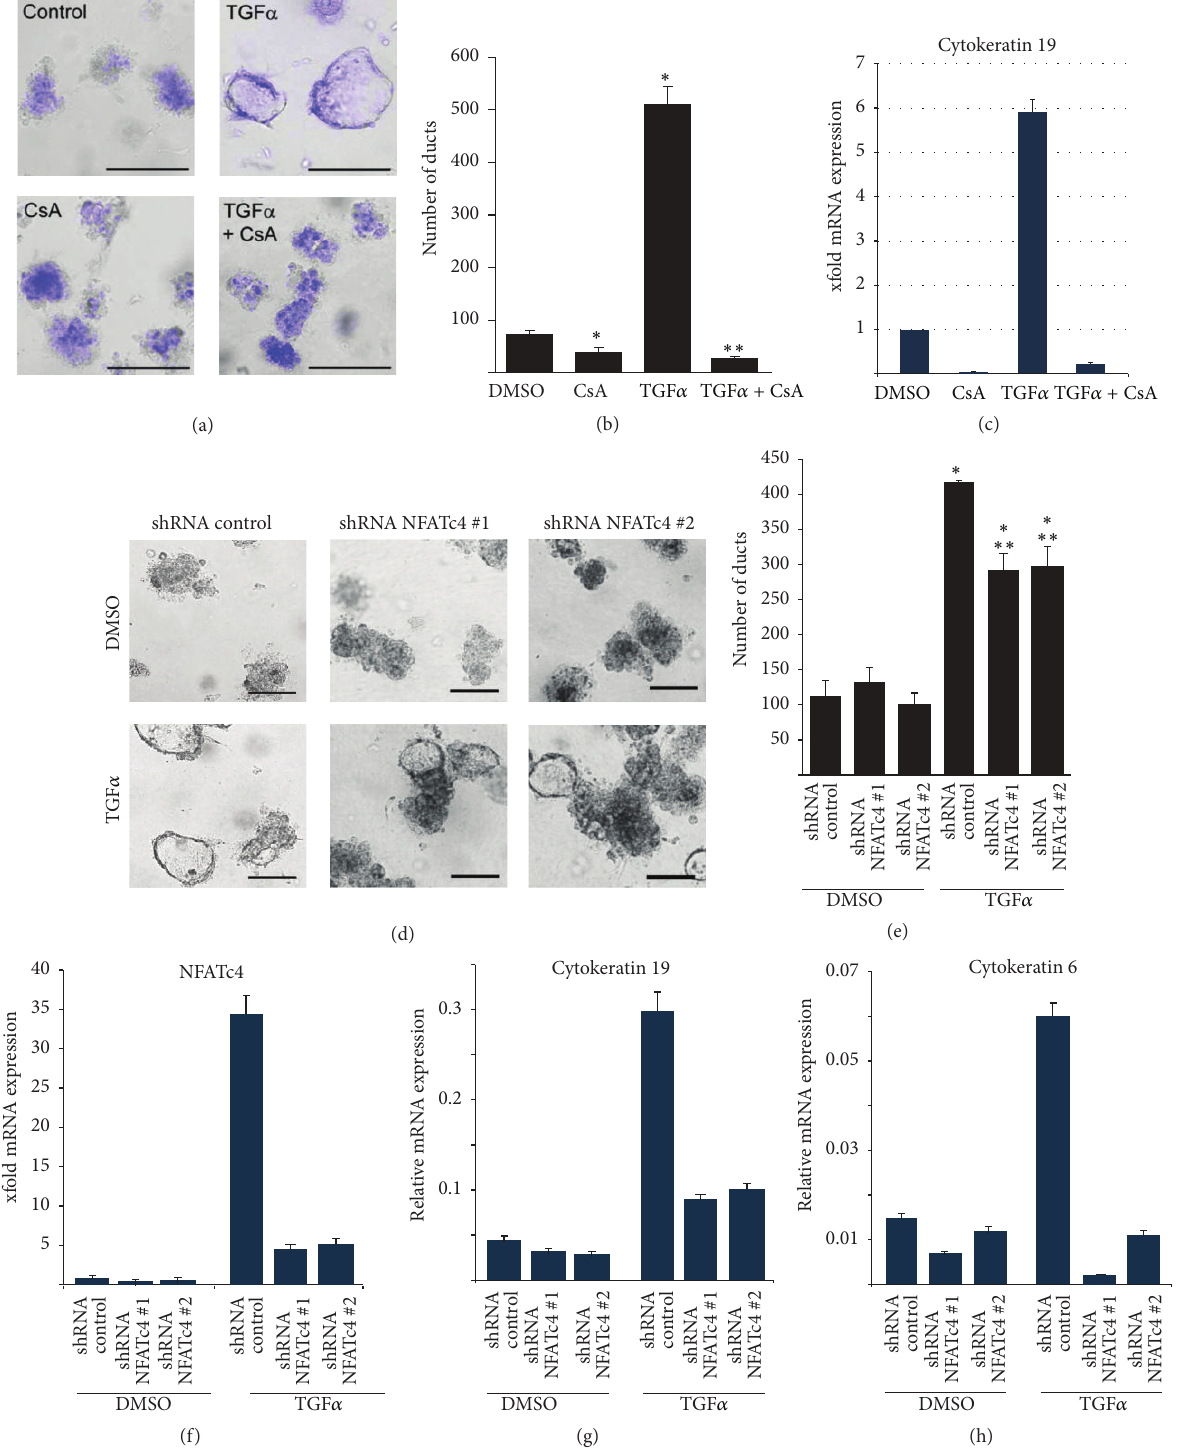
Figure 2: NFATc4 is required for acinar-to-ductal transdifferentiation in the pancreas. (a) Brightfield microscopy reveals acinar cell morphology upon TGF 𝛼 and/or CsA treatment for 5 days (scale bars indicate 100 𝜇 m). Hoechst 33342 was used to stain alive cells embedded in collagen at day 5. (b) Quantification of duct formation was performed five days after acinar cell extraction from wildtype mice. (c) qRT-PCR shows cytokeratin 19 expression in acinar cell explants upon indicated treatments for 5 days. (d)–(h) Acinar cells from wildtype mice were subjected to two different NFATc4 shRNAs or shRNA controls and were stimulated with TGF 𝛼 for 5 days. (d) Brightfield microscopy was conducted to determine acinar cell morphology (scale bars indicate 100 𝜇 m). (e) Quantification of duct formation was performed on day 5 following acinar cell extraction. (f)–(h) mRNA expression levels of the indicated genes were detected on day 5 following acinar cell